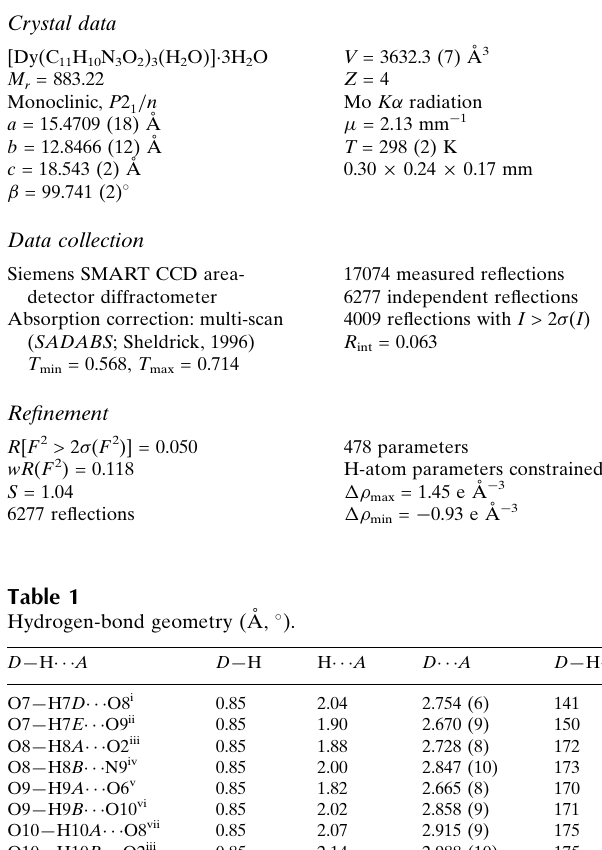
hydrogen-bonding interactions, forming a three-dimensional network structure.